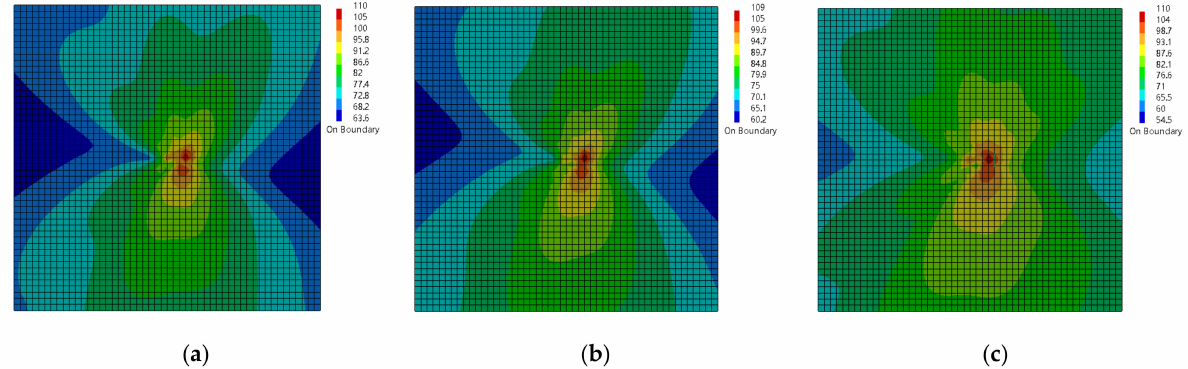
Figure 10. Acoustic radiation field corresponding to different damping thickness (1000 Hz): ( a ) 5 mm; ( b ) 10 mm; ( c ) 20